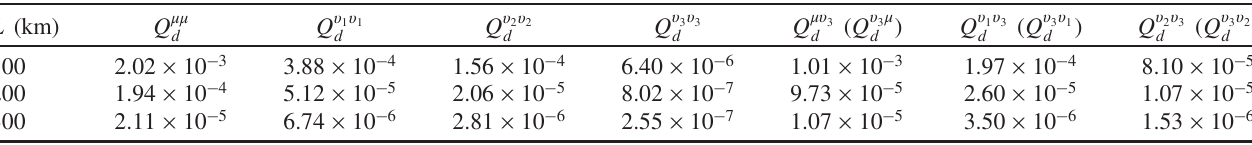
TABLE III. The yields of the decoy